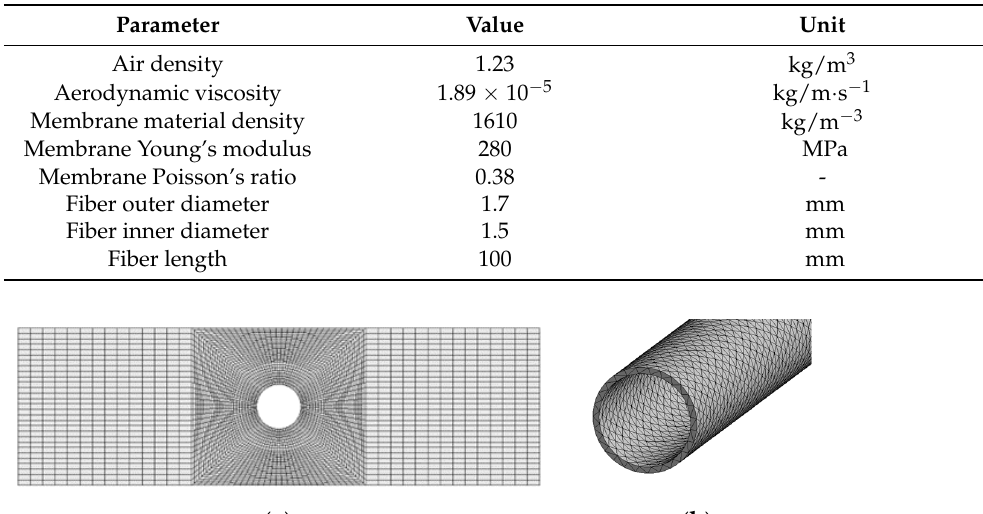
Figure 1. Geometric model. Table 1. Physical properties parameters. Table 1. Physical properties parameters.